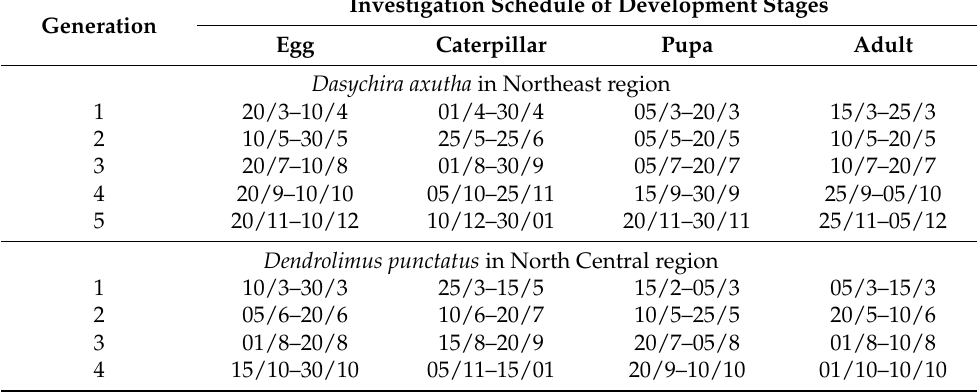
Table 6. Determined schedules for Dasychira axutha in Northeast region and Dendrolimus punctatus in North Central region.